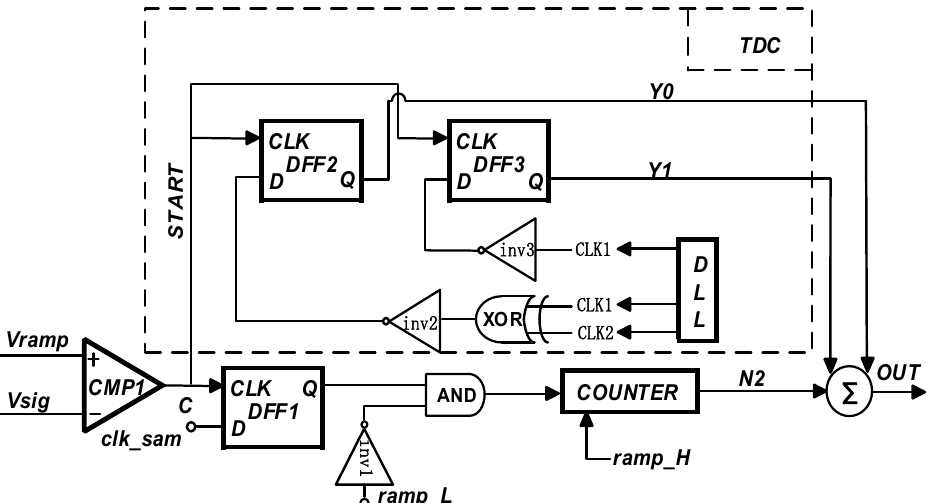
Figure 6. Schematic diagram of TDC coding circuit architecture.